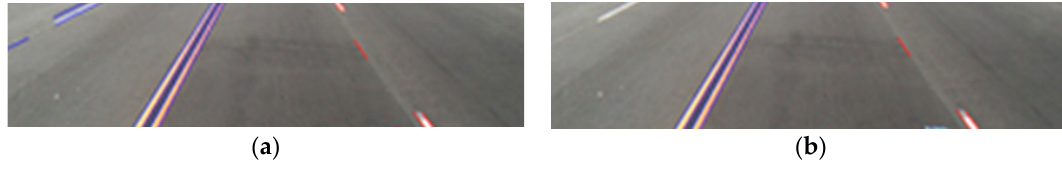
Figure 7. Removing the incorrect line segments based on angle features: ( a ) image including the detected line segments; and ( b ) image with the incorrect line segments removed.